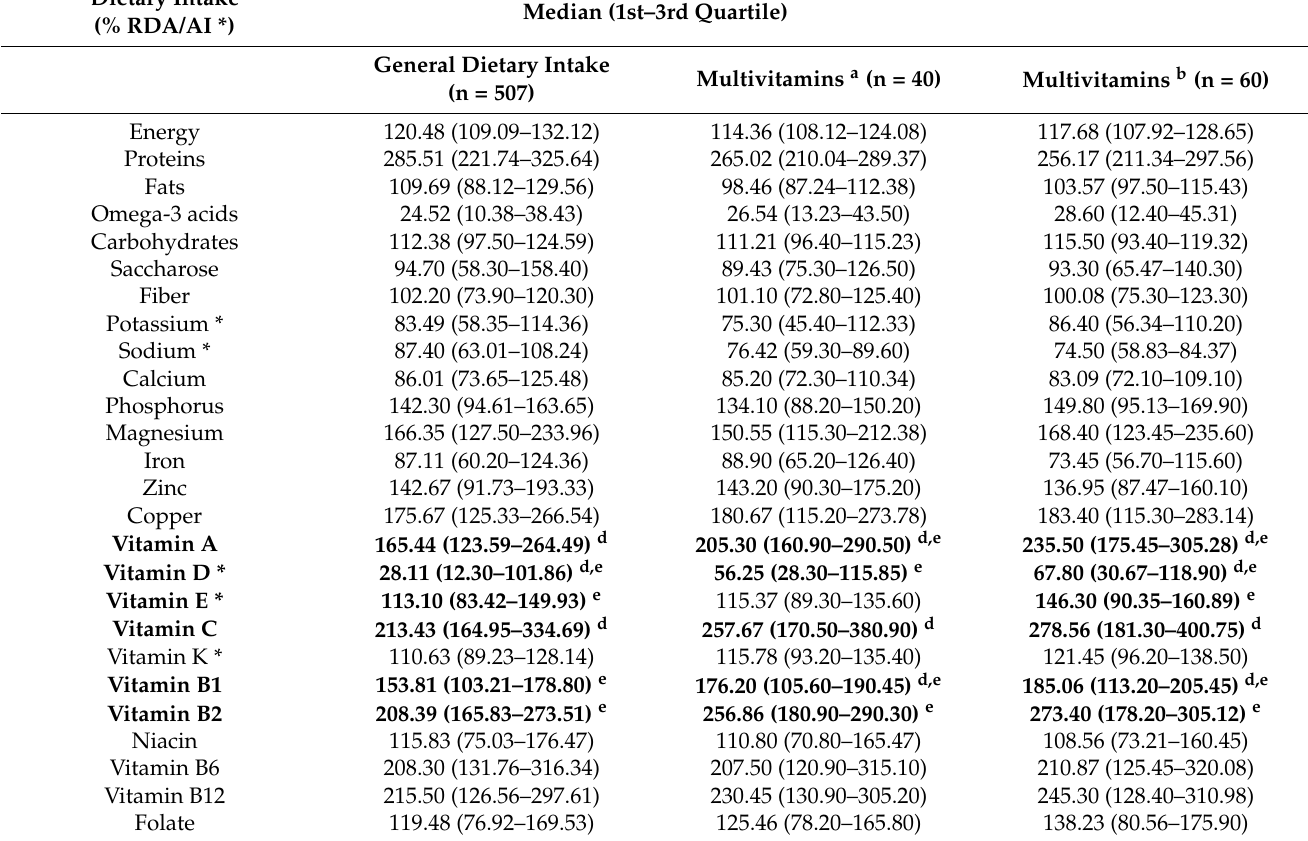
Table 5. Dietary intake in children—general dietary intake and dietary intake taking into considera- tion dietary